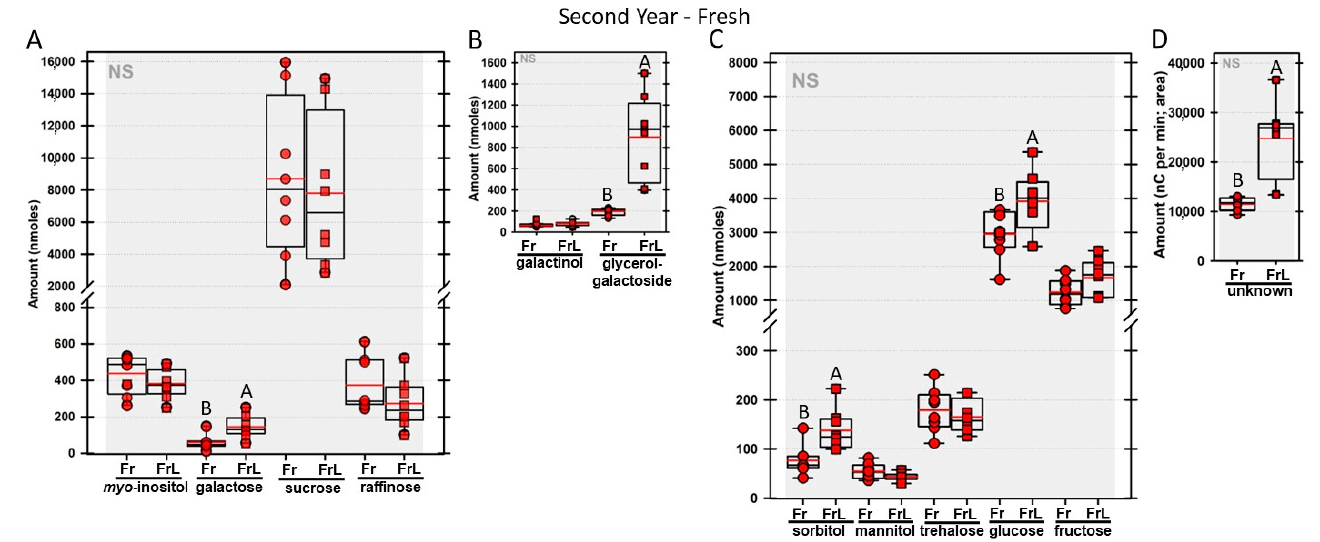
Figure 9. Carbohydrates were analyzed from null segregant (NS) maize leaves. The disks were ground immediately upon harvest (Fr = fresh; red circles) or were lyophilized to dryness without prior exposure to LN 2 (FrL = fresh lyophilized; red squares). The same carbohydrates are depicted, and statistically significant differences are determined in the same manner, as in Figure 4.